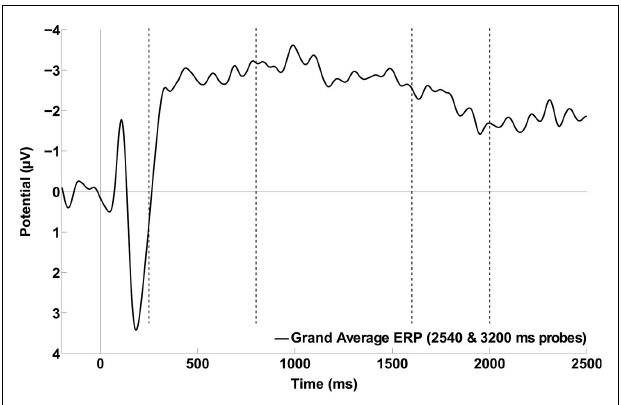
FIGURE 5 | Grand average of the ERP waveforms obtained by collapsing across the six frontal and central electrodes of interest (i.e., FCz, FC1, FC2, C1, C2, and Cz) time-locked to stimulus onset and including only the two longest probe durations. Time window boundaries used to define the various CNV slopes are indicated with vertical dotted lines.The data were smoothed with an eight-point Gaussian window for presentation only.